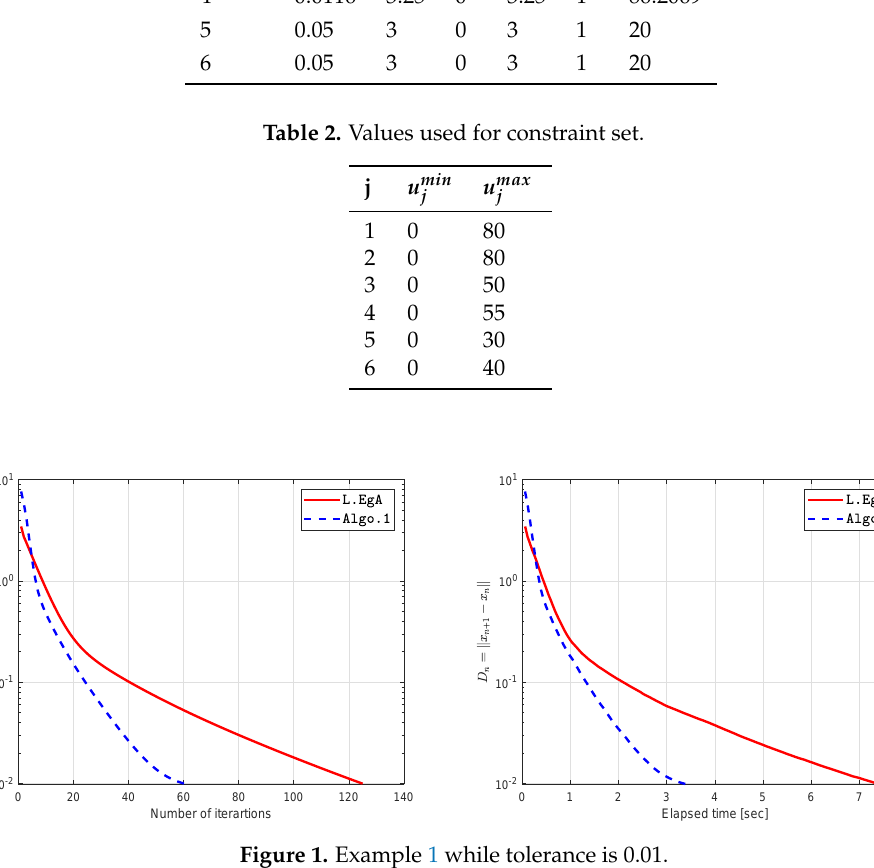
Figure 1. Example 1 while tolerance is 0.01.